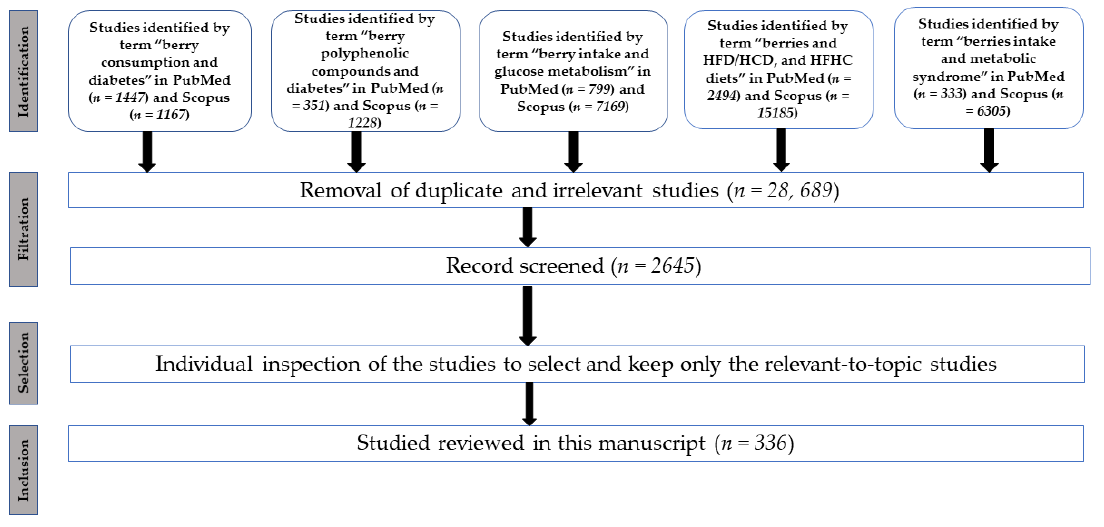
Figure 1. Schematic representation of Preferred Reporting Items for Systematic Reviews and Meta-Analyses (PRISMA) flow diagram collection and selection of studies included in this review. Adapted from Moher, Liberati [8].